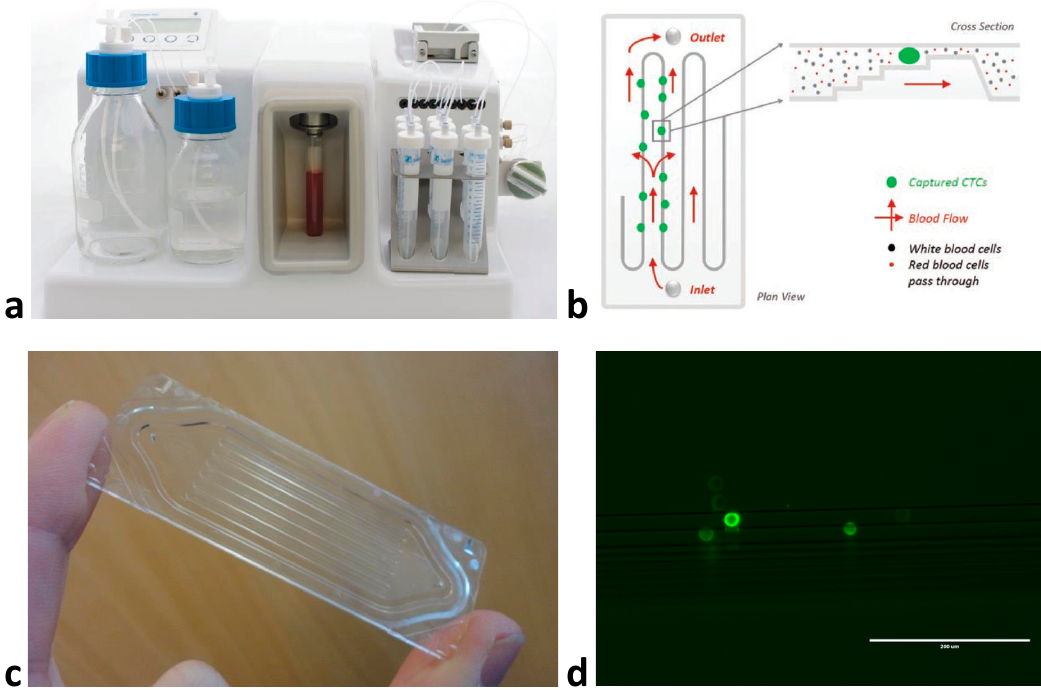
Figure 2. An example of CTC enrichment using a microfluidic device: ( a ) the Parsortix ™ (Angle Plc) system, ( b ) diagram of microfluidic flow and cell sorting within the isolation cassette, ( c ) Close-up of the isolation cassette demonstrating tiered multi-channel design, ( d ) head and neck squamous cell carcinoma cells (FaDu cell line) isolated from spiked blood sample using Parsortix ™ and stained with pan-cytokeratin antibody (Parsortix ™ enriches CTCs ≈ 1000-fold, however anti-CD45 staining is also required to negatively select the contaminating white blood cell population or deplete CD45 + ve cells to provide a pure CTC population) at 20× magnification.